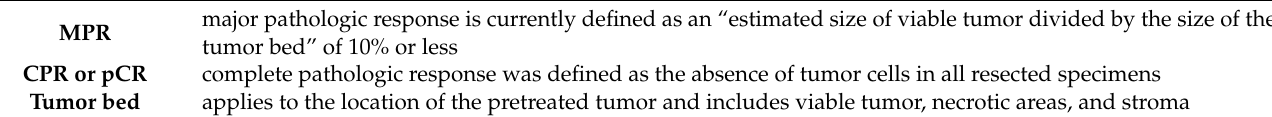
Table 2. Surrogate measures of efficacy of neoadjuvant